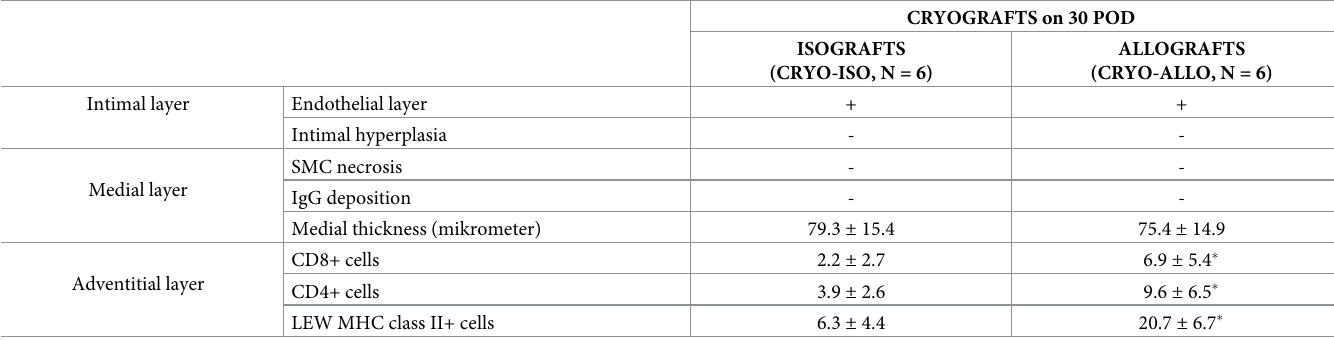
Table 3. Histological and immunohistological parameters of cryopreserved aortal grafts under study on day 30 posttransplant.